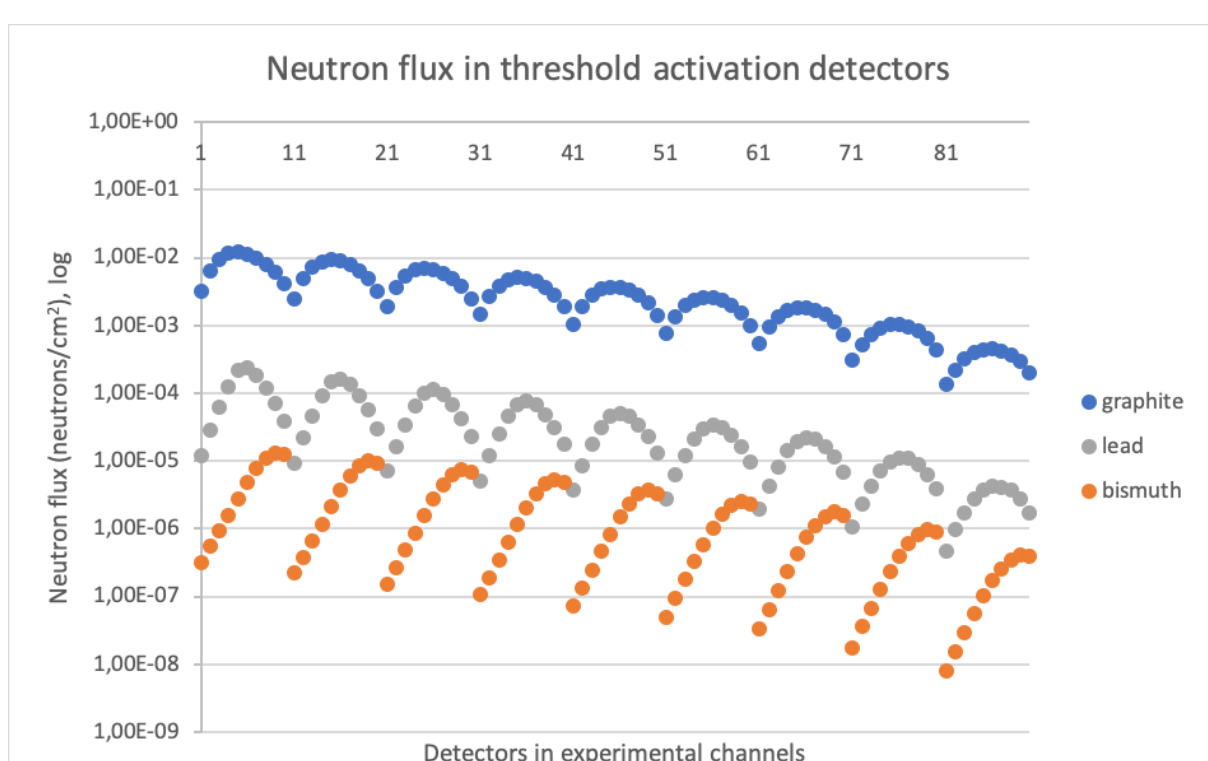
Table 1. Nuclear data libraries for MCNP calculations